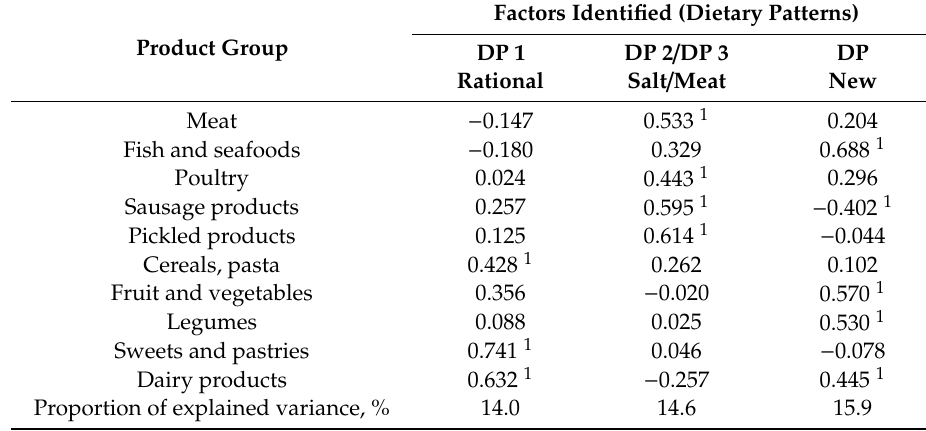
Table A10. Factor loadings of the principal dietary patterns identified (Vologda region).